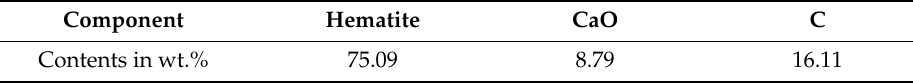
Table 2. Composition of the charge for reduction roasting.